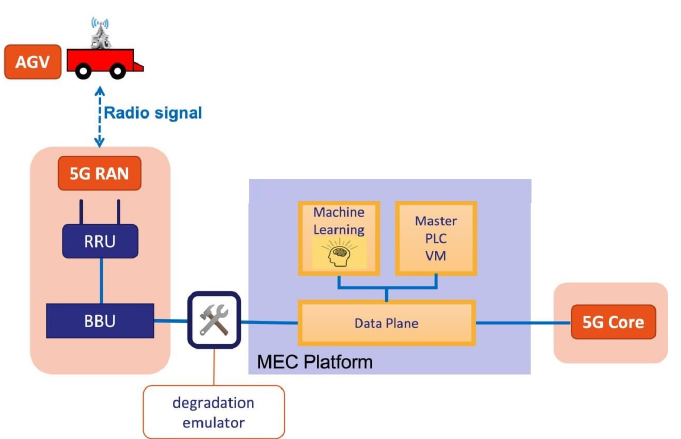
Figure 1. Use case architecture representing the AGV, 5G RAN, 5G MEC, 5G CORE, and ML